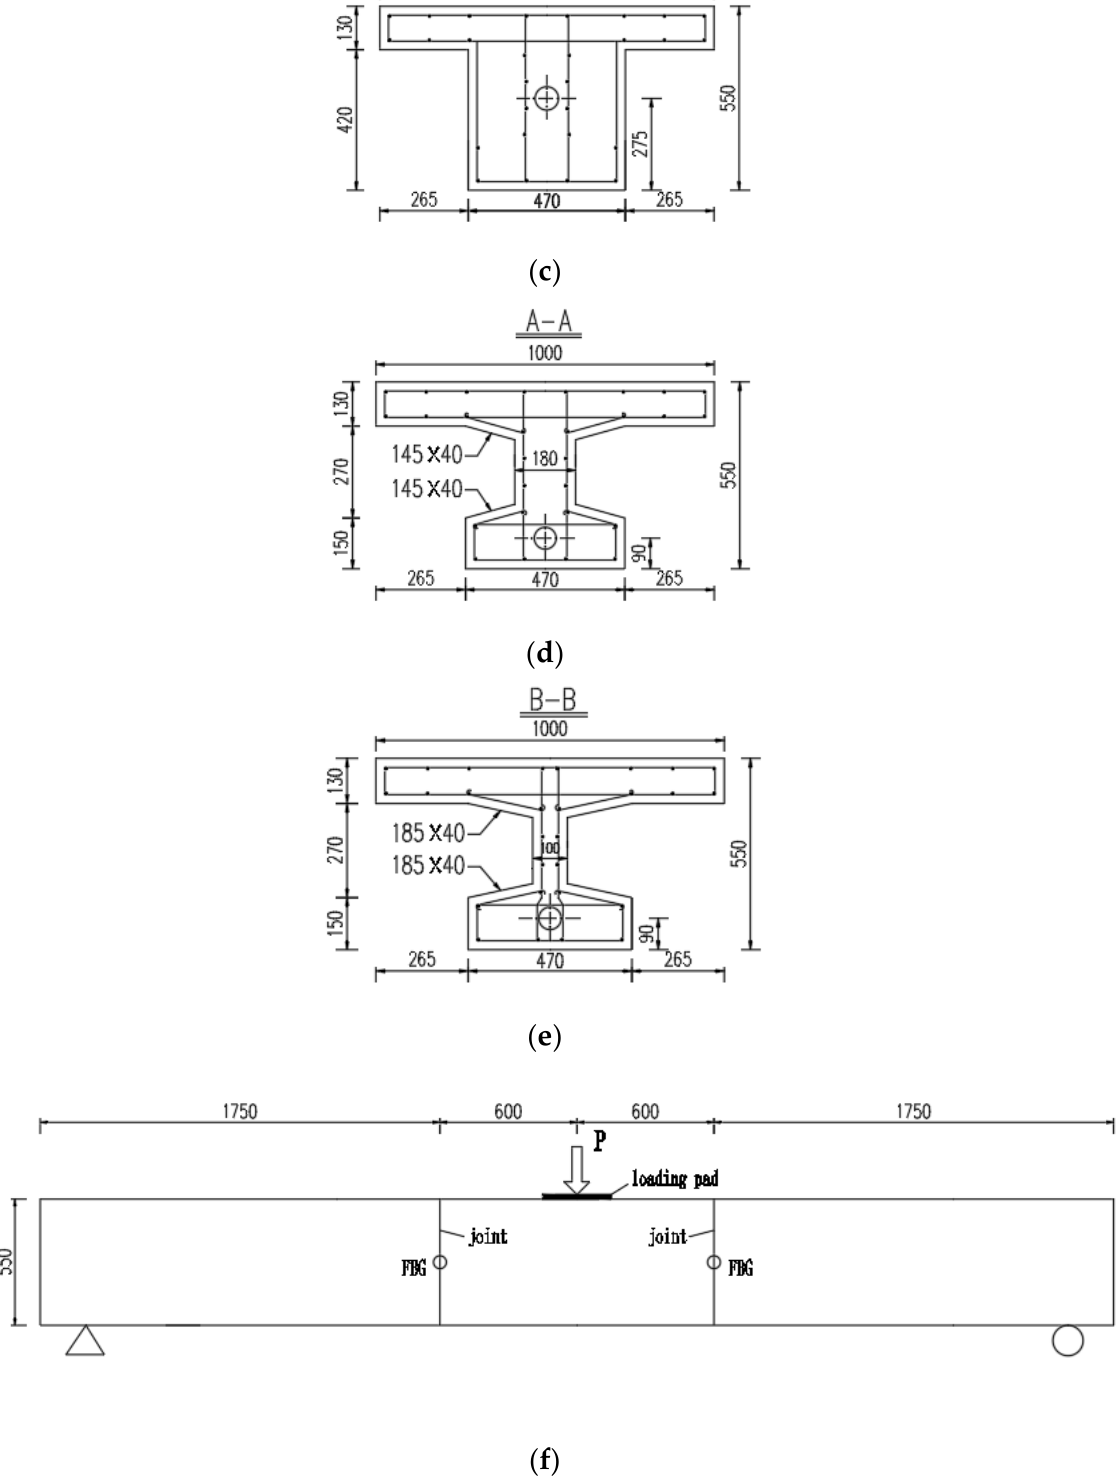
Figure 2. Schematic diagram of the girder specimen (unit: mm). ( a ) Dimensions of the girder specimen. ( b ) Layout of curved prestressed steel strands of the girder specimen. ( c ) C-C Section. ( d ) A-A Section. ( e ) B-B Section. ( f ) Loading and test system.